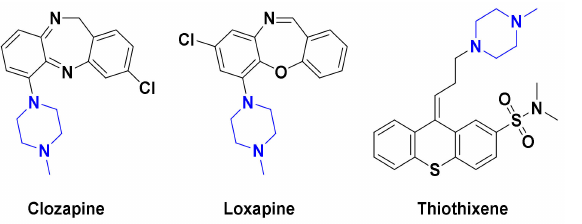
Figure 1. Representative examples of CNS acting FDA-approved drugs possessing N